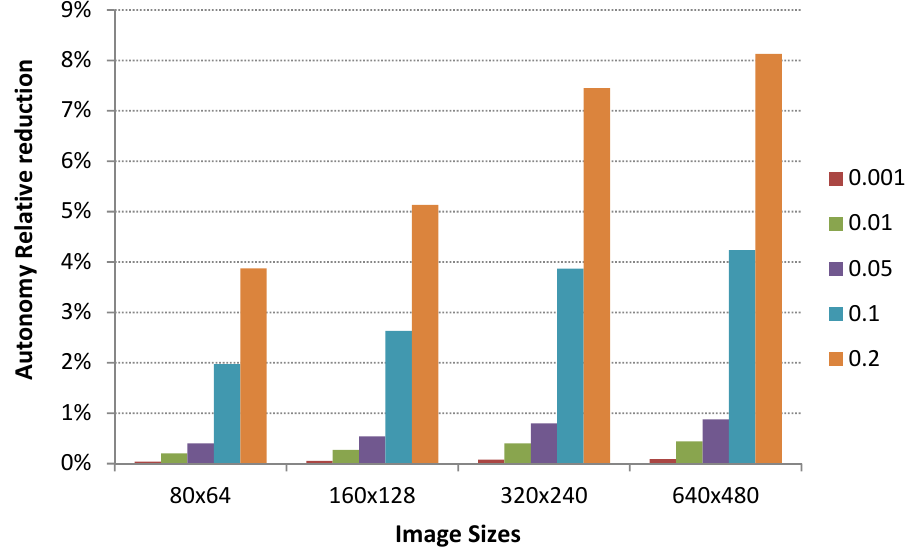
Figure 8. Autonomy relative reduction due to packet delivery errors. Results are given for each available image size working at maximum capture frequency (1 image every 30 min) and different packet error rates (from 1 out of 1,000 up to 1 out of